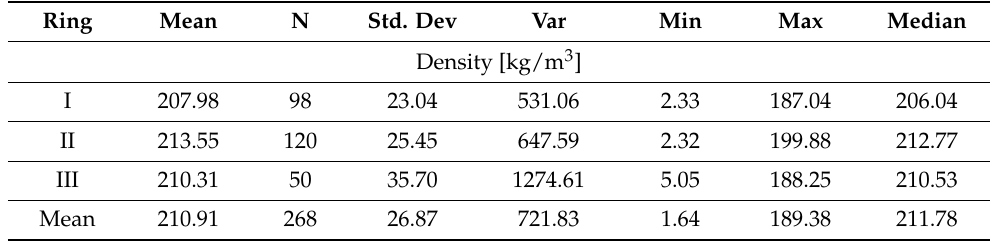
Table 8. Pearson correlation of examined properties at breast height: density, modulus of elasticity, tensile strength, and strength-to-density coefficient. Table 9. Basic statistical parameters of the density [kg/m 3 ], tensile strength, modulus of elasticity [MPa], and strength-to-density coefficient [km] of samples divided by annual rings, from the pith (I) to the bark